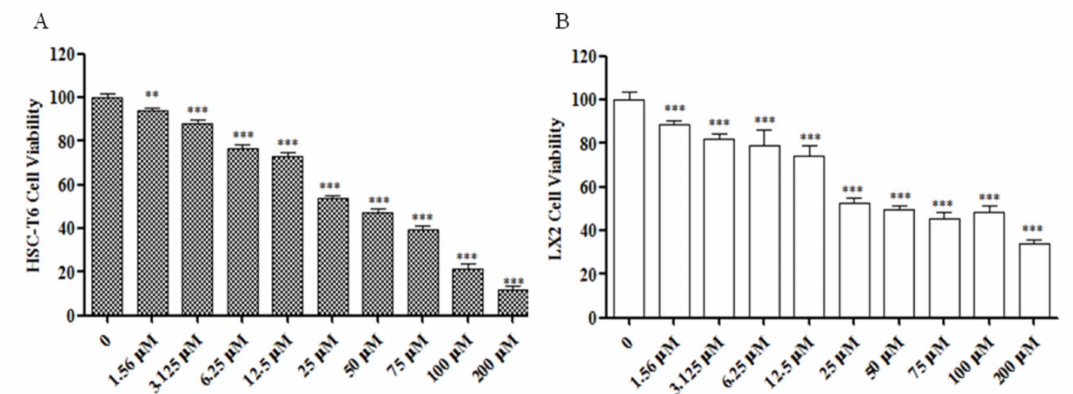
Figure 1. Sch B inhibited the viability of activited HSC-T6 and LX-2 cells. ( A ) Effect of Sch B on the viability of HSC-T6 cells shown by CCK8 assay. ( B ) Effect of Sch B on the viability of LX-2 cells shown by CCK8 assay. The results are presented as means ± SD, ** p < 0.01, *** p < 0.001 compared with the TGF- β 1